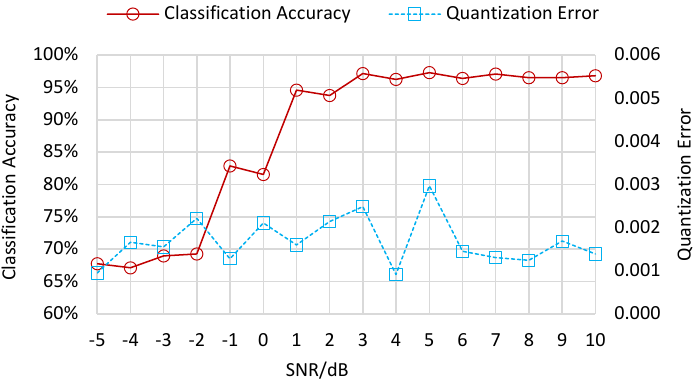
Figure 9. Classification accuracy and quantization error of the root layer under different SNRs.